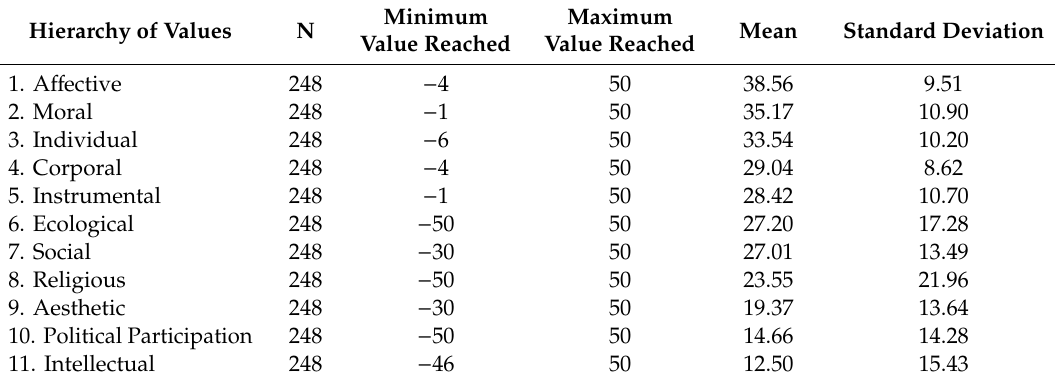
Table 2. Hierarchy of values of religious school students (Salesian pedagogical